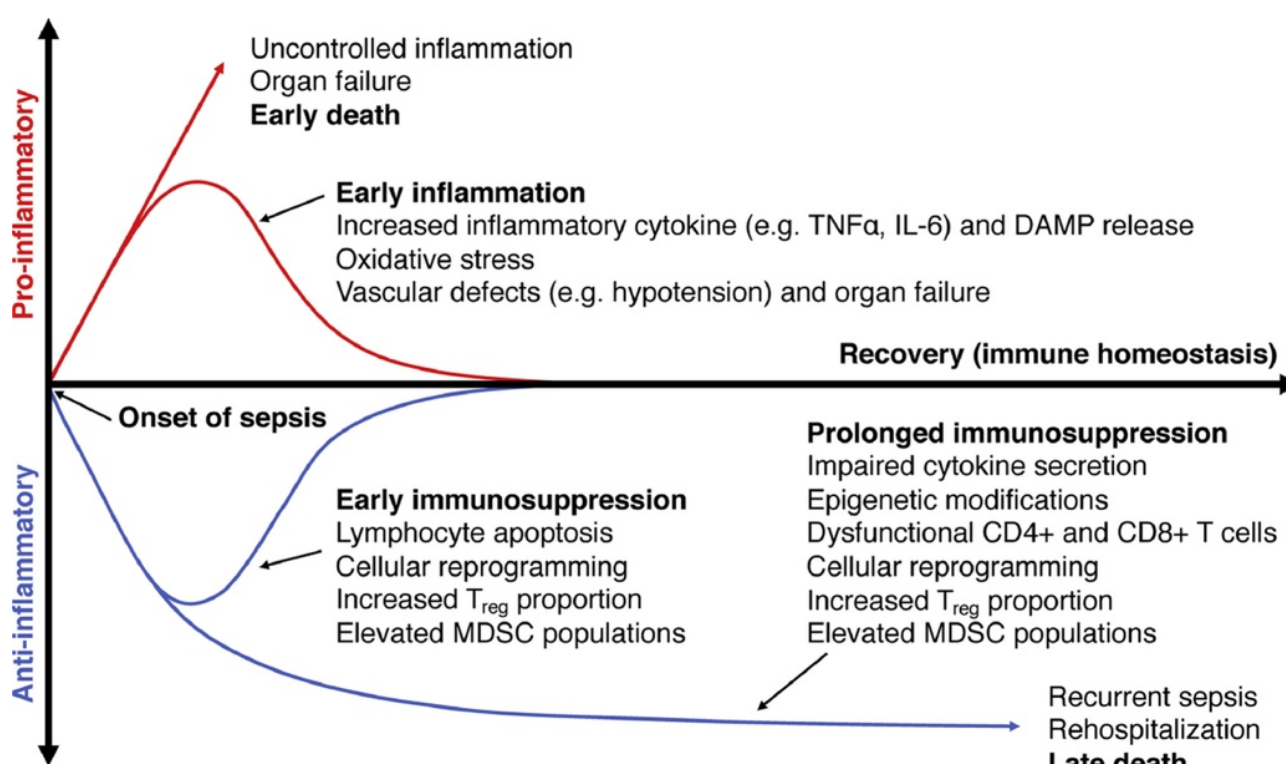
Figure 6. Stages of sepsis. Early in sepsis, both inflammation and immunosuppression occur concurrently. If inflammation is uncontrolled, this leads to organ failure and death. Those that avoid early death will either return to immune homeostasis, or progress to prolonged immunosuppression that continues after discharge. Prolonged immunosuppression predisposes survivors to infections, rehospitalizations, and ultimately to death. This phenomenon is marked by impaired cytokine secretion, dysfunctional T cells, and cellular reprogramming. Expansion of regulatory T cell and myeloid-derived suppressor cell (MDSC) populations also occurs early in sepsis and persists after sepsis, suggesting their role in maintaining this immunosuppressive phenotype.